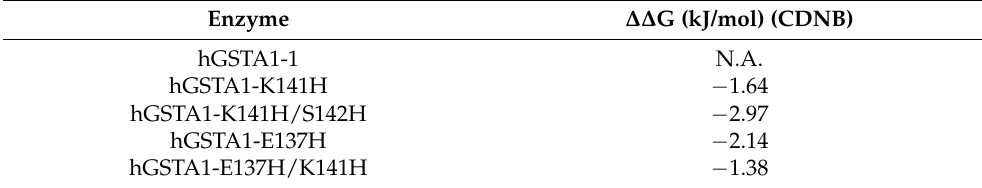
Table 2. The contribution of each mutation in the difference free energy change (ΔG) for stabiliza- tion of the transition state (ΔΔG).